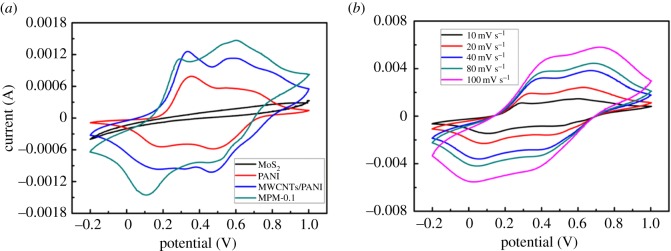
(a) CV curves of MoS2, PANI, MWCNTs/PANI and MPM-0.1 at 10 mV s−1 in 1 M H2SO4 electrolyte and (b) CV curves of MPM-0.1 nanocomposite at different scan rates (10 mV s−1, 20 mV s−1, 40 mV s−1, 80 mV s−1, 100 mV s−1) in 1 M H2SO4.